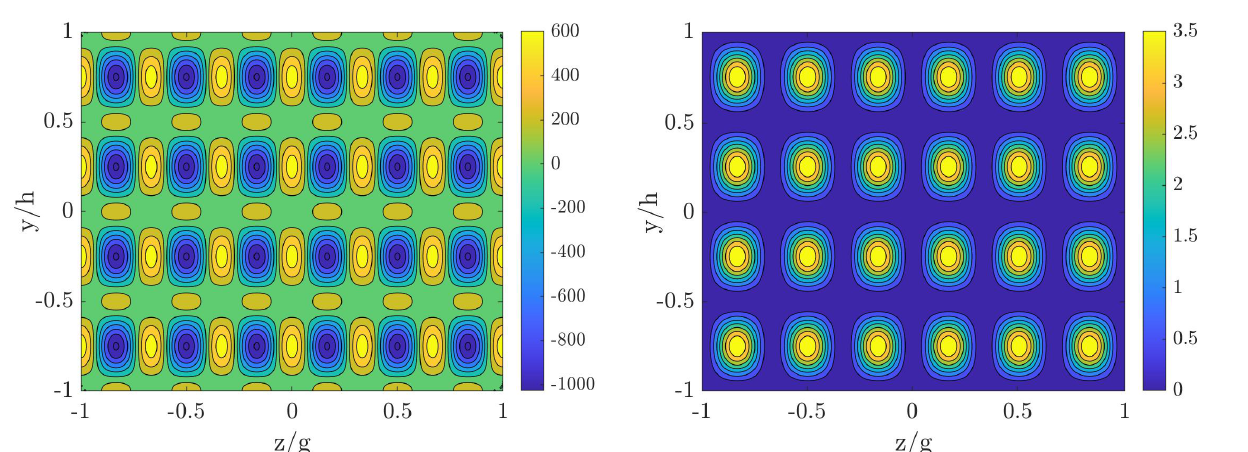
Figure 5. (Left column) Φ and (right column) V distributions for α = 0.01 on a 383 × 383 grid, for m = 4, n = 6. ( Top ) Particular solution, Equation (31); ( Middle ) homogeneus solution, Equation (32) for X l = 7 (the logarithm of Φ is shown to improve readability); and ( Bottom ) solution, Equation